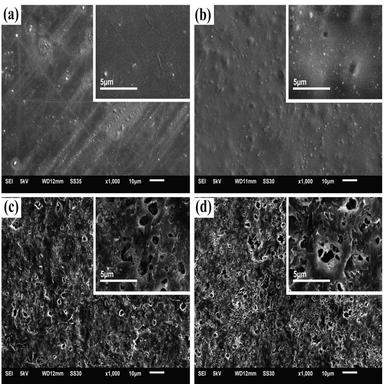
SEM micrographs of surfaces for PVC films and PVC porous films: (a) 0 v%, (b) 10 v%, (c) 20 v%, (d) 50 v%.